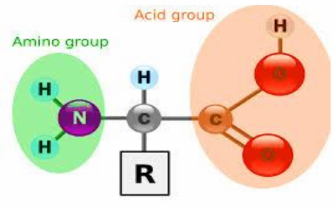
Figure 1. Structure of amino